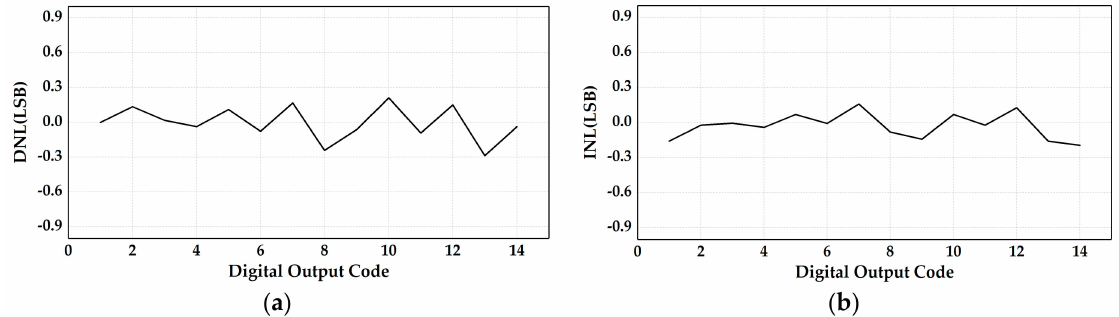
Figure 16. Measured ( a ) INL and ( b ) DNL performance after